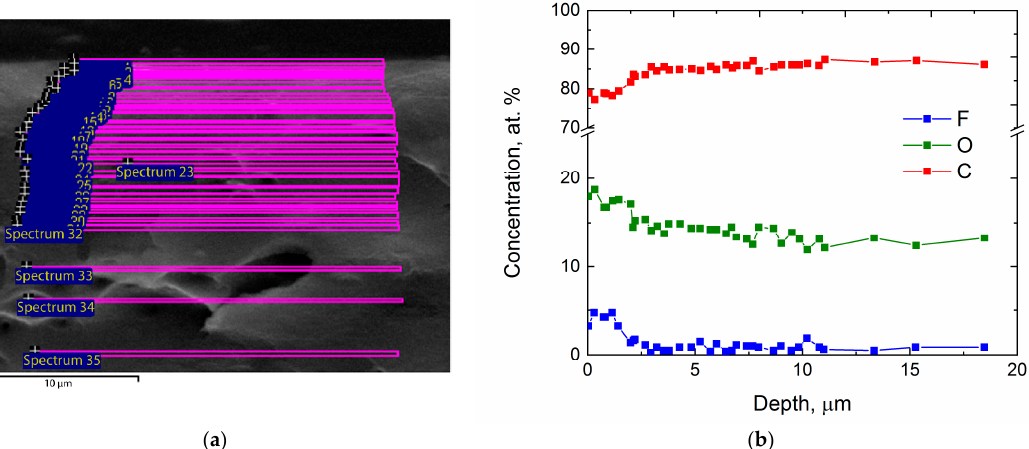
Figure 2. A typical set of results for a single film sample: ( a ) a scanning scheme of cross-section of the sample on a SEM-image, ( b ) graphical representation of distribution of element concentration on the depth.